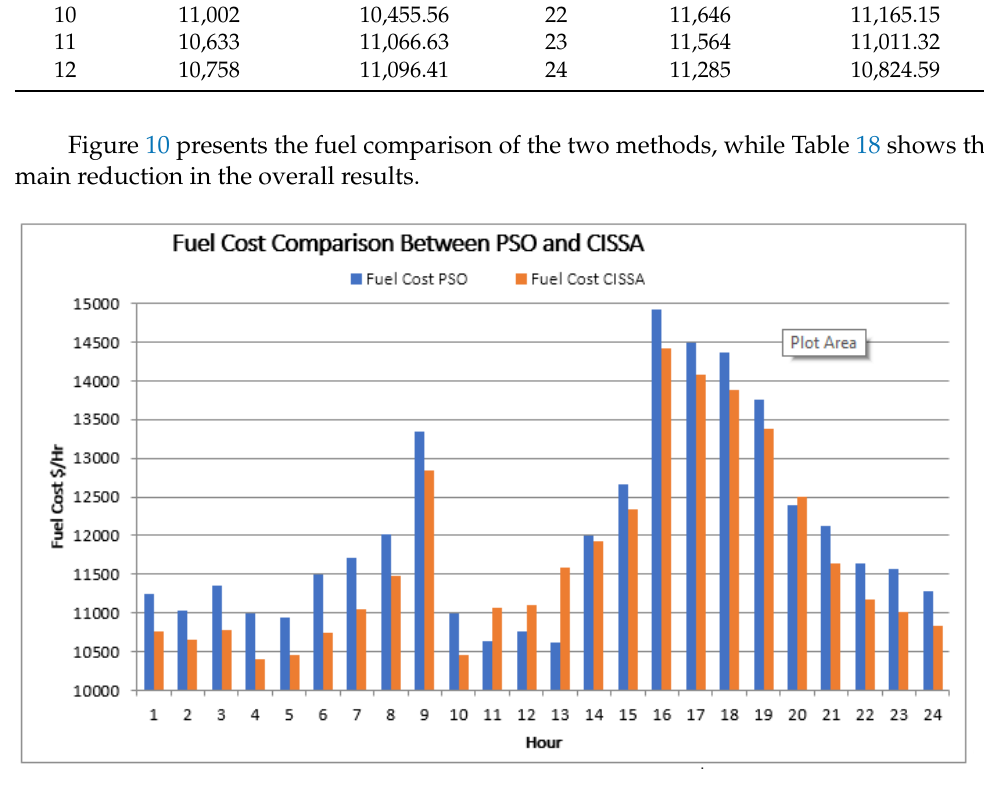
Figure 10. Fuel cost comparison between CISSA and PSO. Table 18. Reduction in daily fuel cost — case study 2.